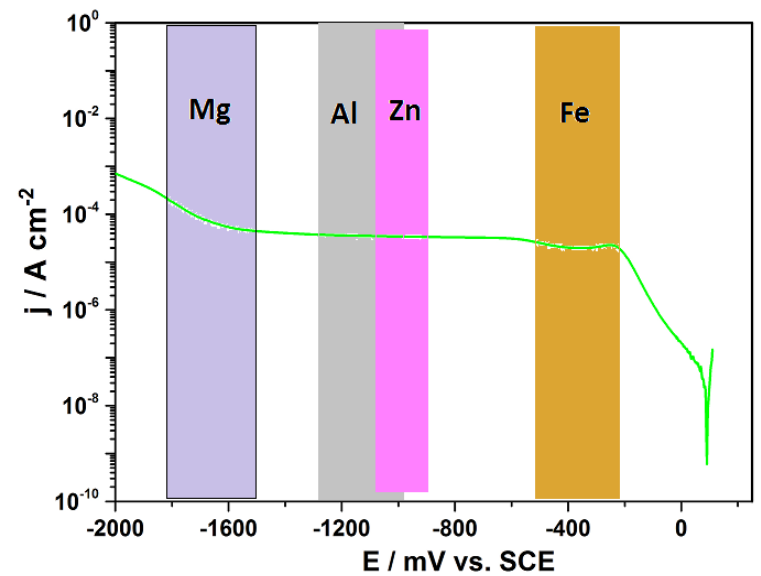
Figure 2. Cathodic potentiodynamic polarization curve of carbon fiber reinforced polymer acquired at a scan rate of 1 mV s − 1 in quiescent 50 mM NaCl showing the potential ranges each metal can polarize CFRP and the operative cathodic current densities on CFRP in these potential ranges.